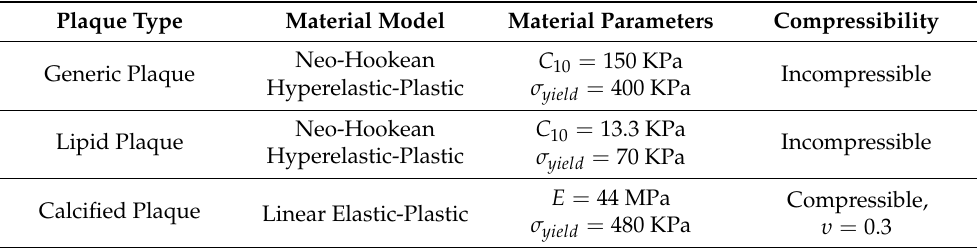
Table 3. Summary of the material models and parameter values adopted for the mechanical descrip- tion of the generic plaque, the lipid plaque, and the calcified plaque. For each plaque type, an ideal plastic behavior was